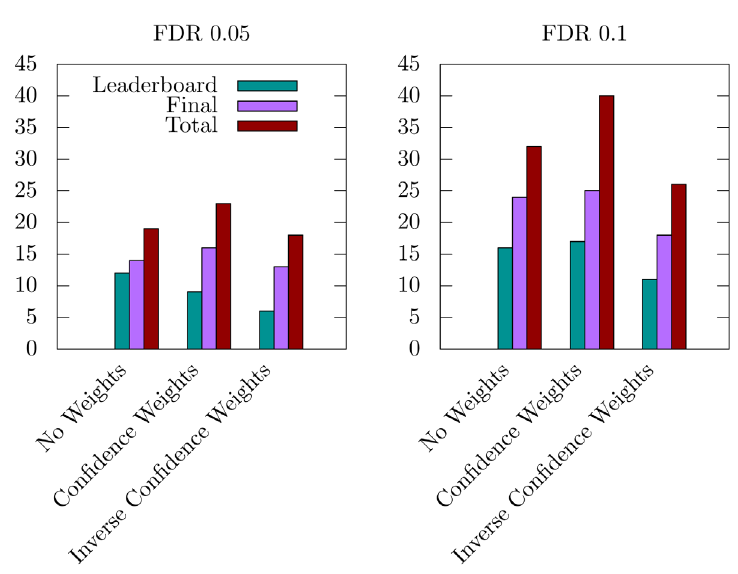
Figure 4. Number of significant disease modules identified with FDR thresholds 0.05 and 0.1, and from three different inter-layer weightings: No Weights , i.e., equal weights for all layers (585 modules in total), Confidence Weights , i.e., weights proportional to the expected biological relevance: 1-ppi=1, 2-ppi=1, 3-path=1, 4-coexpr=0.5, 5-cancer=0.1, 6-homology=0.1 (555 modules in total), and Inverse Confidence Weights , i.e., weights inversely proportional to the expected biological relevance: 1-ppi=0.1, 2-ppi=0.1, 3-path=0.1, 4-coexpr=0.5, 5-cancer=1, 6-homology=1 (648 modules in